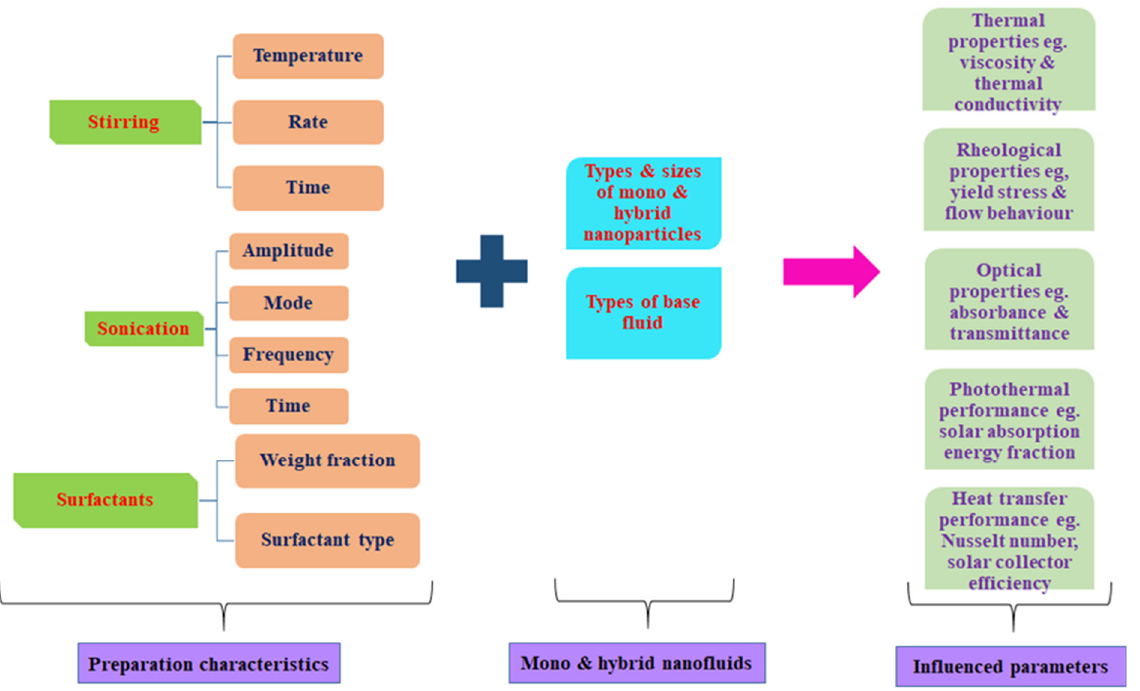
Figure 24. Influence of preparation characteristics on properties (optical, thermal, and rheological) and performance of mono and hybrid NFs.